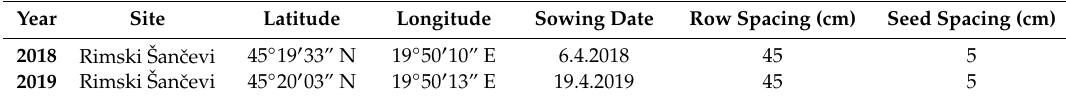
Table 1. Year and location (latitude and longitude) of the experimental trials along with the sowing date and row and seed spacing, for the experimental trials in 2018 and 2019. Year Site Latitude Longitude Sowing Date Row Spacing (cm) Seed Spacing